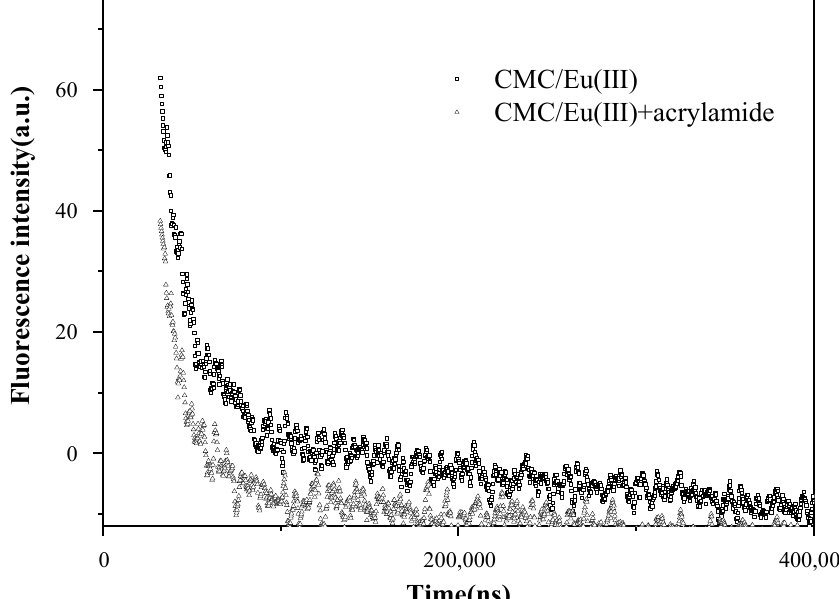
Figure 11. Emission lifetime of CMC/Eu (III) probe in the absence and presence of acrylamide (0.1 mmol/L).